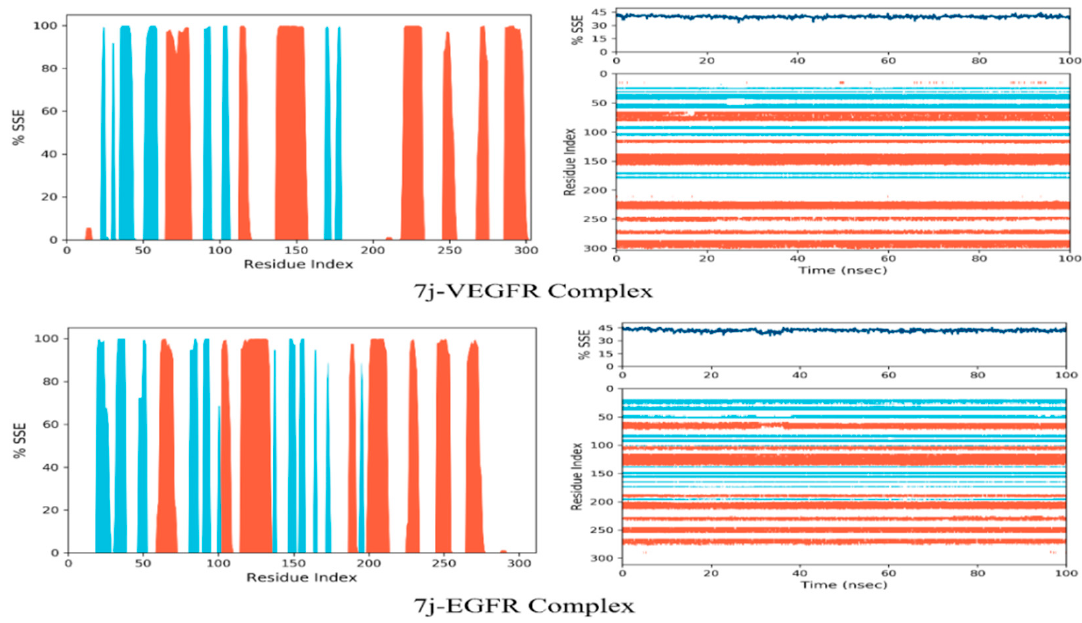
Figure 12. Residue index throughout the protein structure of complexes 7j-VEGFR 2 and 7j-EGFR showing alpha helices (Red) and beta-strands (Blue) .